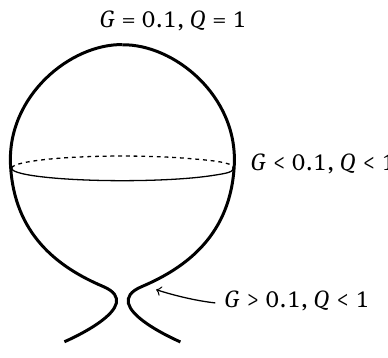
Figure 1: A surface of revolution can have all circles about the origin stable but some other circles isoperimetric, where the Gauss curvature is larger. The trick is to have the Gauss curvature decrease when the circumference is large and increase when the circumference is